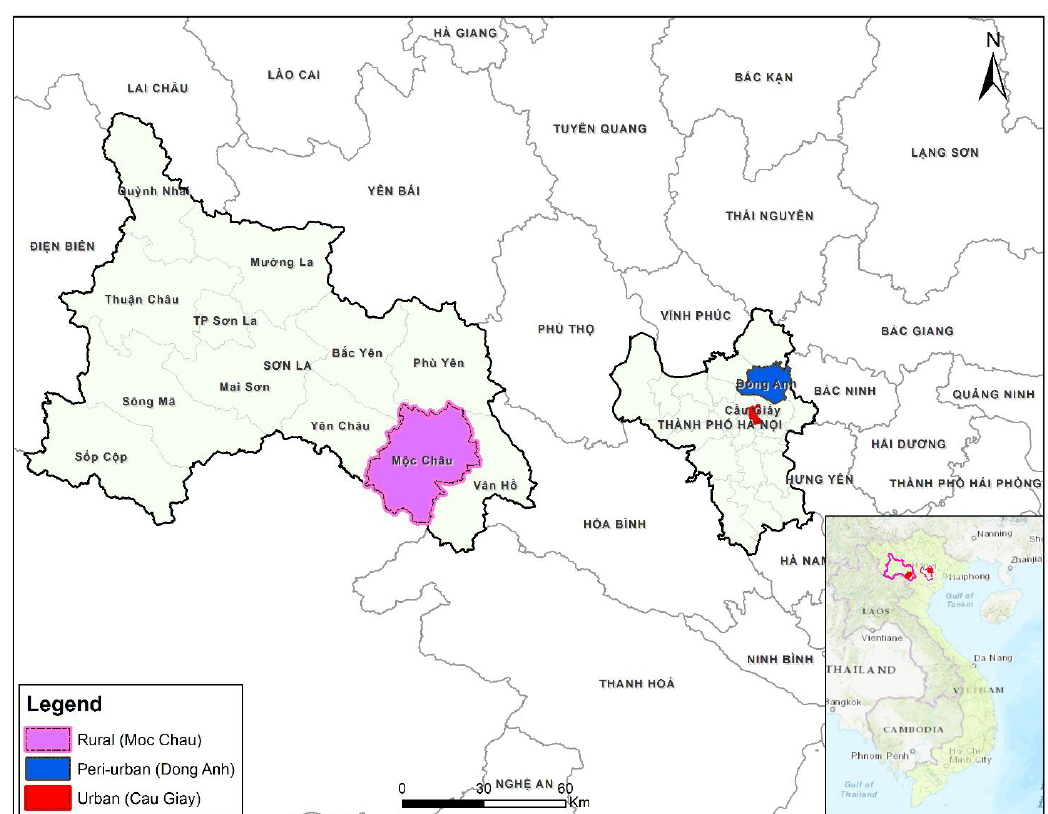
Figure 1. Maps of three districts surveyed and analyzed in this study.